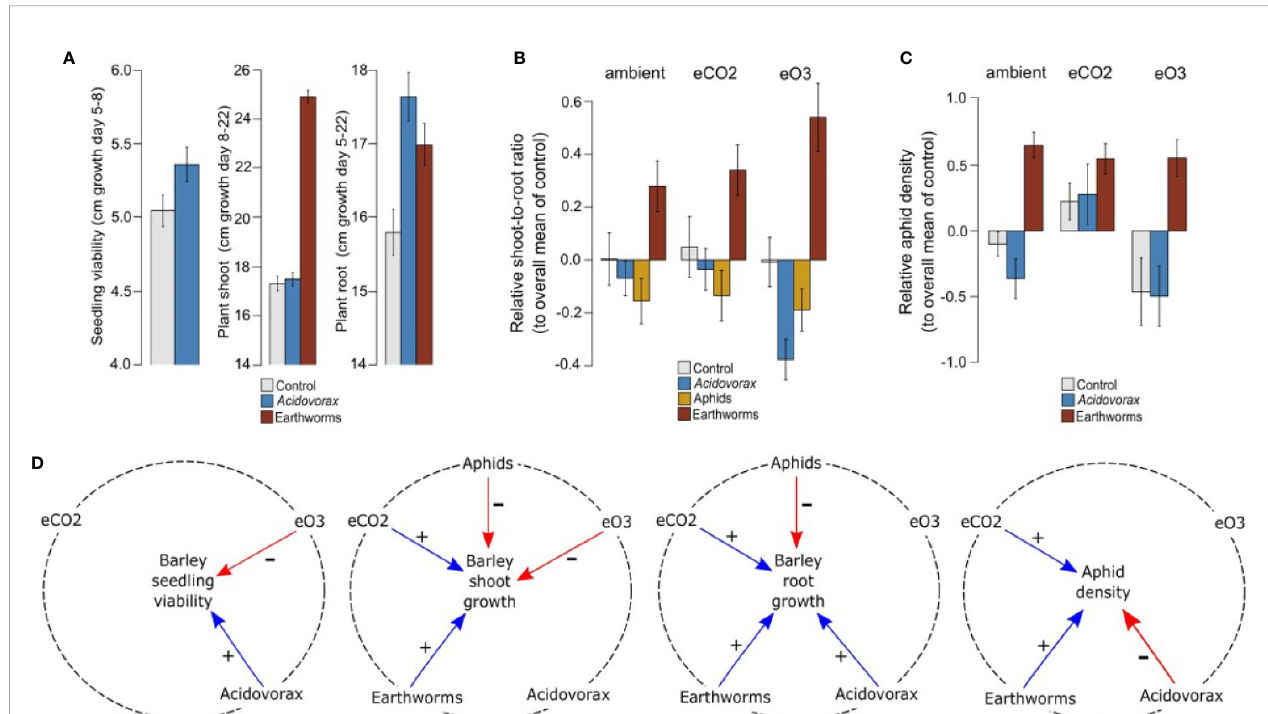
FIGURE 1 | Plant and insect growth across biotic and climate treatments. (A) Absolute early seedling growth (seedling shoot length difference, day 5 – 8, cm), later shoot growth (longest shoot length difference, day 8 – 22, cm), and root length (day 5 – 22, cm) across Acidovorax radicis and earthworm treatments, averaged across all barley cultivars. (B) Relative shoot-to-root ratio and (C) relative aphid load (compared to controls, by plant cultivars and experimental runs), across abiotic (climate) and biotic ( A. radicis , aphids and earthworm) treatments. Error bars are ±1 SE (D) Summary of interactions showing positive effects (+) in blue (on the variable in the centre of each circle), negative effects (-) in red, and the dotted line shows the factors linked by